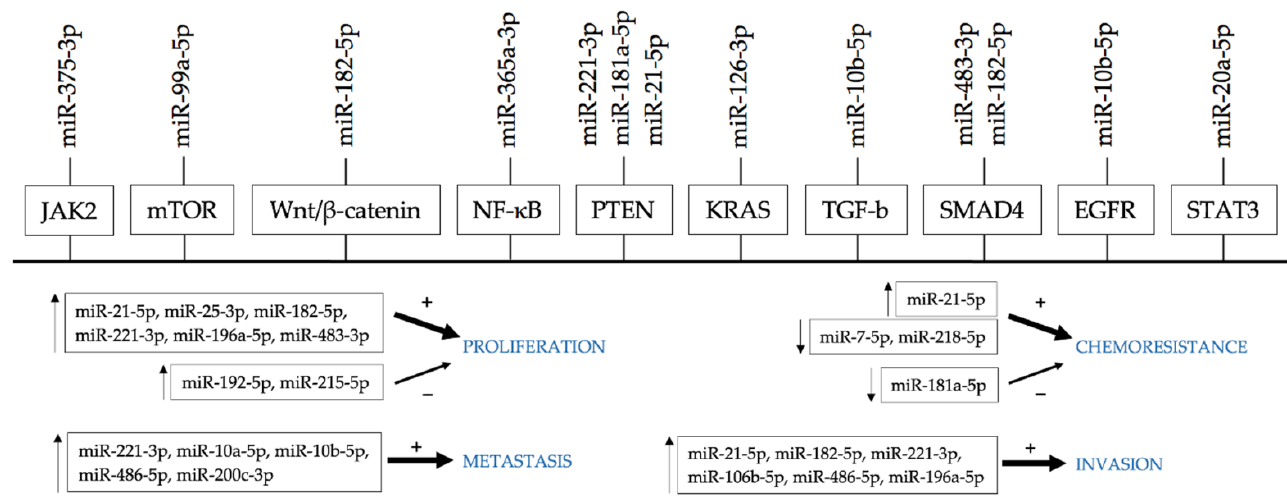
Figure 2. Many miRNAs physiologically regulate the activity of oncogenes and tumor suppressor genes at balance. Up- ( ↑ ) or downregulation ( ↓ ) of particular miRNAs affects the activity of crucial signaling pathways and cancer hallmarks, such as sustained cell proliferation, invasiveness , and metastasis. Deregulated miRNAs are also involved in chemo- resistance.